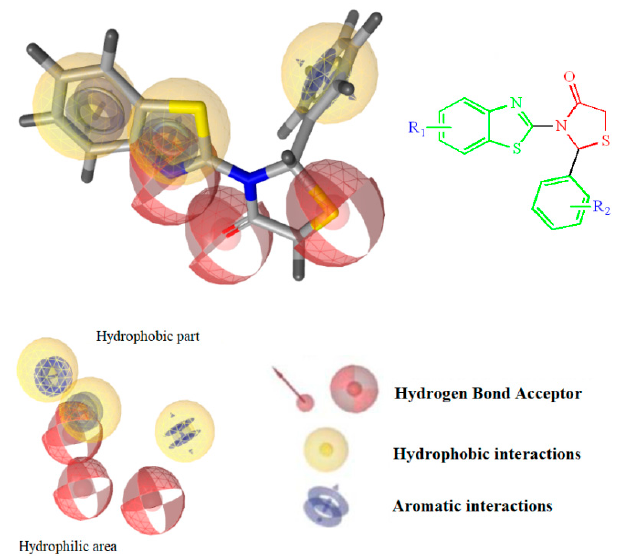
Figure 1. Structure and Basic Characteristics of the Designed Compounds.